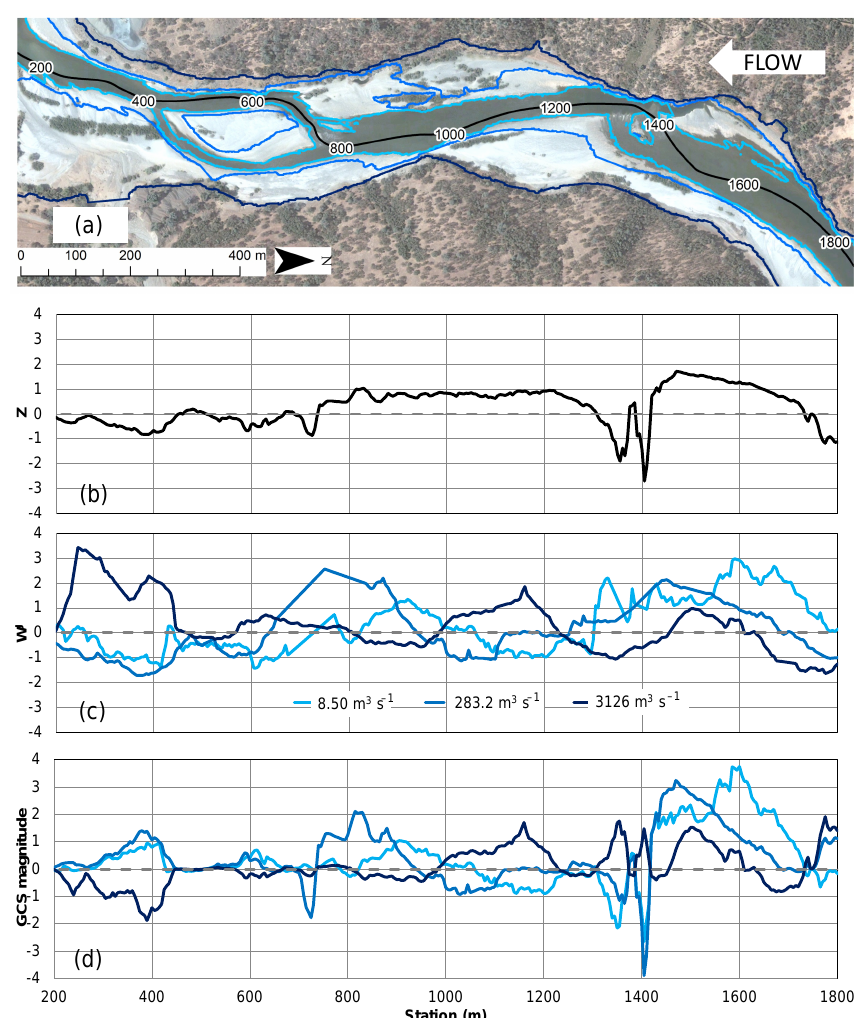
Figure 4. Example section in the middle of the study area showing inundation extents (a) . Below are plots of minimum bed elevation (b) , flow widths for 8.50, 283.2, and 3126m 3 s − 1 ( C ), and C 28 September